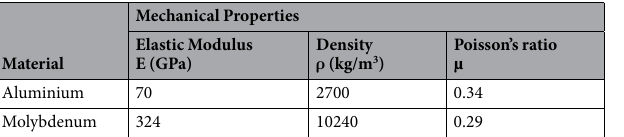
Table 1. Mechanical properties of materials selected for the fabrication of Material Contrast lens, as obtained using conventional bulk ultrasonic pulse-echo testing.